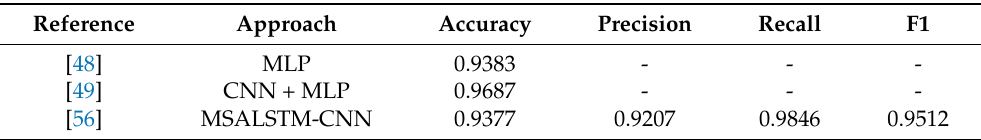
Table 11. Performance of surveyed works for sensor performance application. Values were averaged due to multiple results being